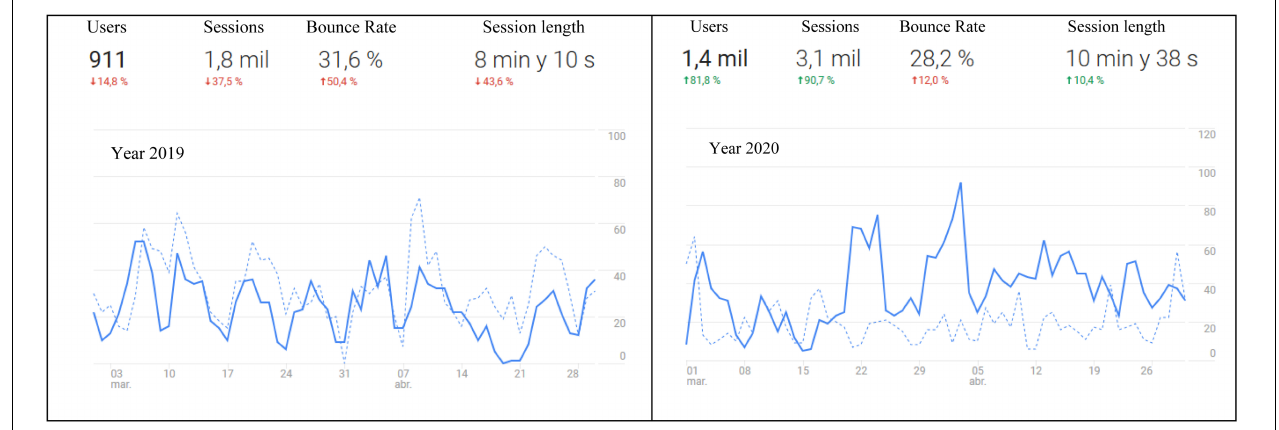
FIGURE 1 | MenPas users (March and April ’19 vs. March and April ’20) by Google analytic.